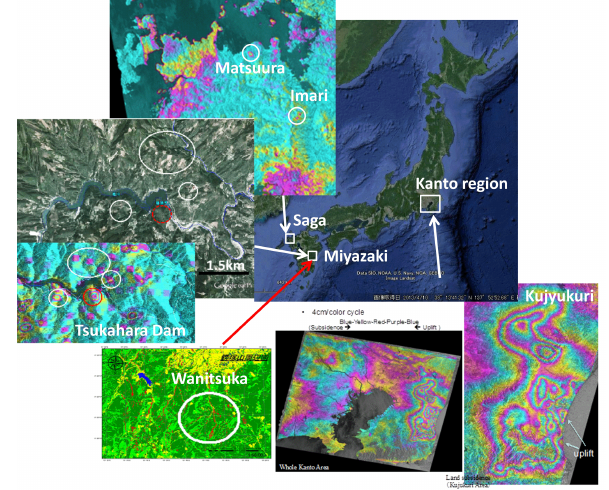
Figure 1. Map of study area and results of InSAR analysis.